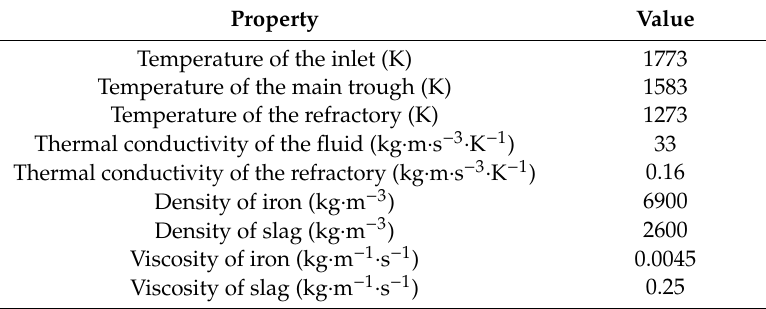
Figure 1. Schematic diagram of the main trough in front view: 1-1 cross-section view at the main trough; 2-2 cross-section view at the outlet. Table 1. Physical properties of the mixture and the refractory.